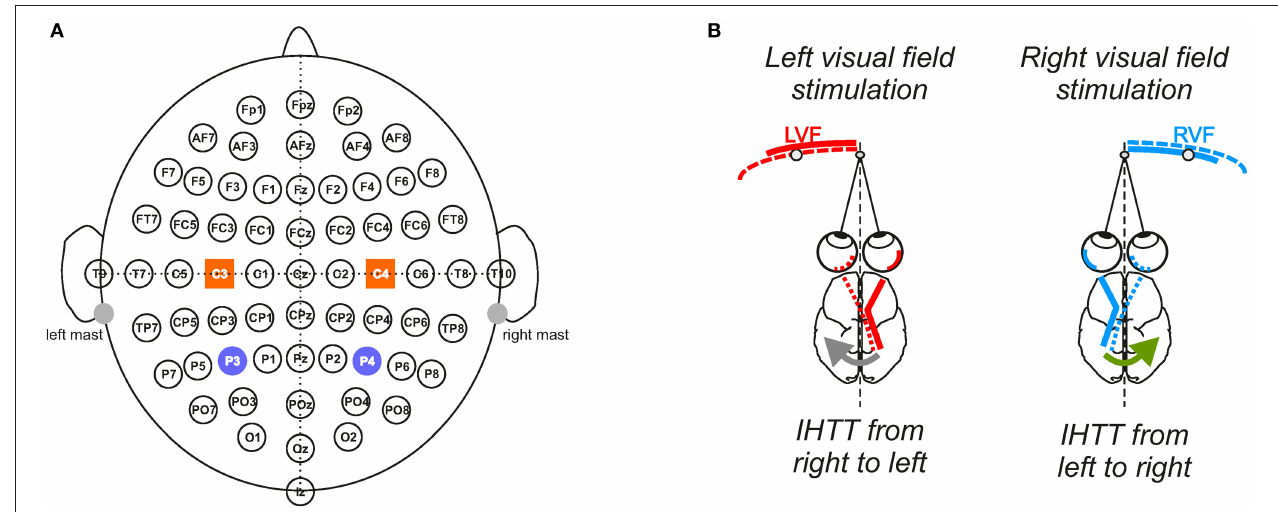
FIGURE 1 | Experimental setup and conditions. (A) Electrophysiological recordings. Throughout the 10 blocks of 100 trials, electrophysiological recordings were performed from 64 electrodes in accordance with the extended 10/20 system. To analyze interhemispheric transfer time, we focused our analyses on the activities recorded over the posterior parietal (P3/P4) and central sites (C3/C4) depicted here as violet circles and orange squares, respectively. (B) Computation of the interhemispheric transfer time. Given the crossed organization of visual neural pathways, the direct response to the visual stimulation was recorded over the contralateral hemisphere whereas the indirect response, i.e., after interhemispheric transfer, was recorded over the ipsilateral hemisphere to the stimulation. Difference between the latencies of N160 peak (most negative deflection around 160ms) recorded over both hemispheres gave an estimation of the interhemispheric transfer time (IHTT) from right to left (gray arrow) when the target appeared in LVF and from left to right (green arrow) when it appeared in RVF.